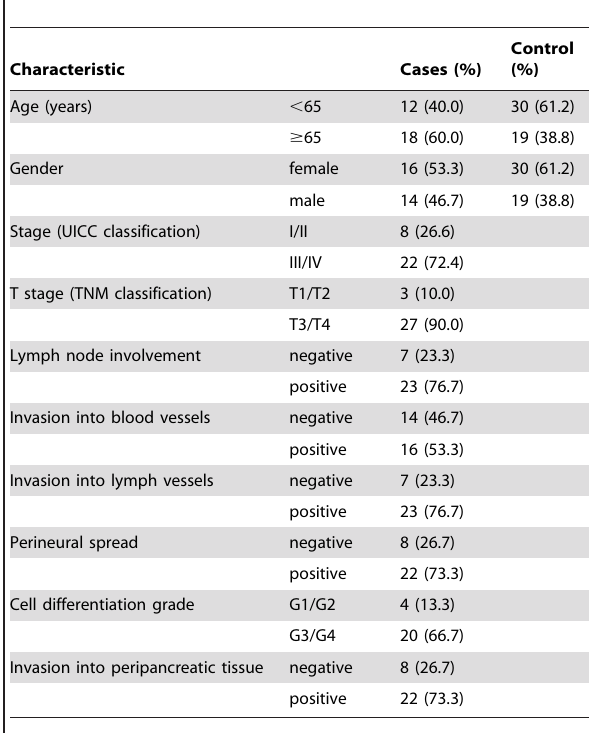
Table 1. Clinical characteristics of patients included in this